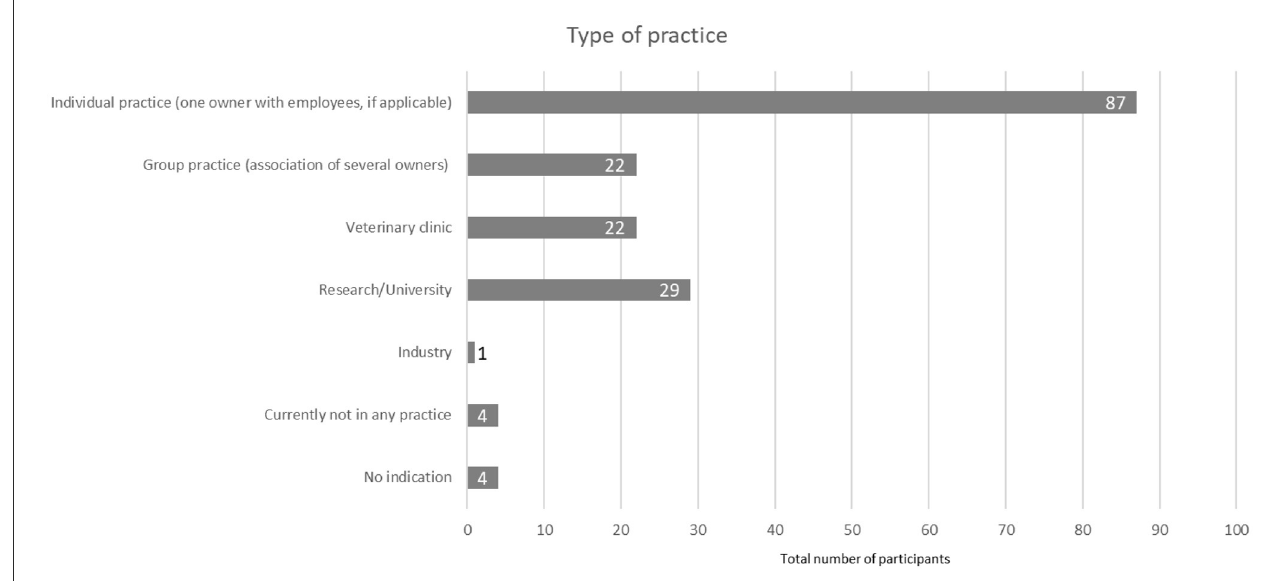
FIGURE3 Type of practice in which respondents worked ( N = 169).